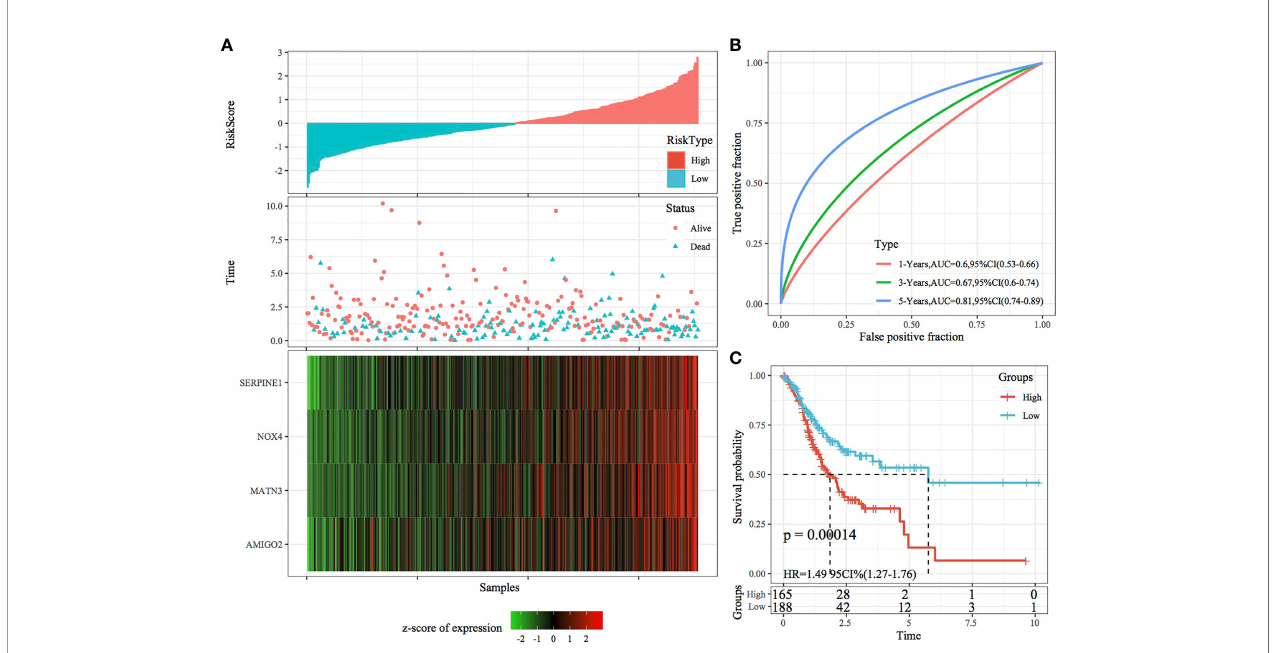
FIGURE 8 | Validation of the four-gene signature in the whole TCGA dataset. (A) RiskScore, survival status and the expression of four genes in the whole TCGA dataset. (B) ROC curve and AUC of the four-gene signature. (C) KM curve demonstrating survival predicted by the four-gene signature in the whole TCGA dataset.